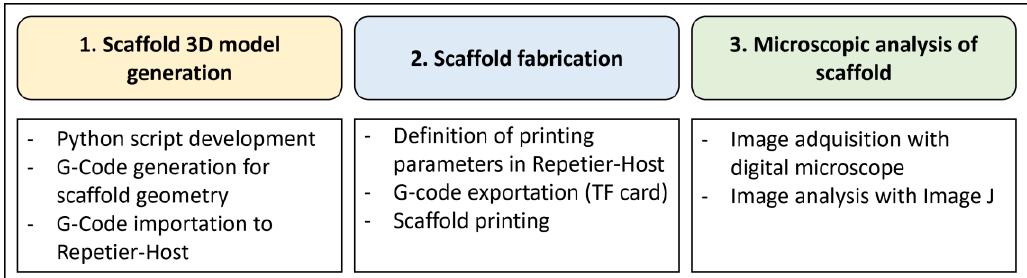
Figure 2. Stages of the methodology.